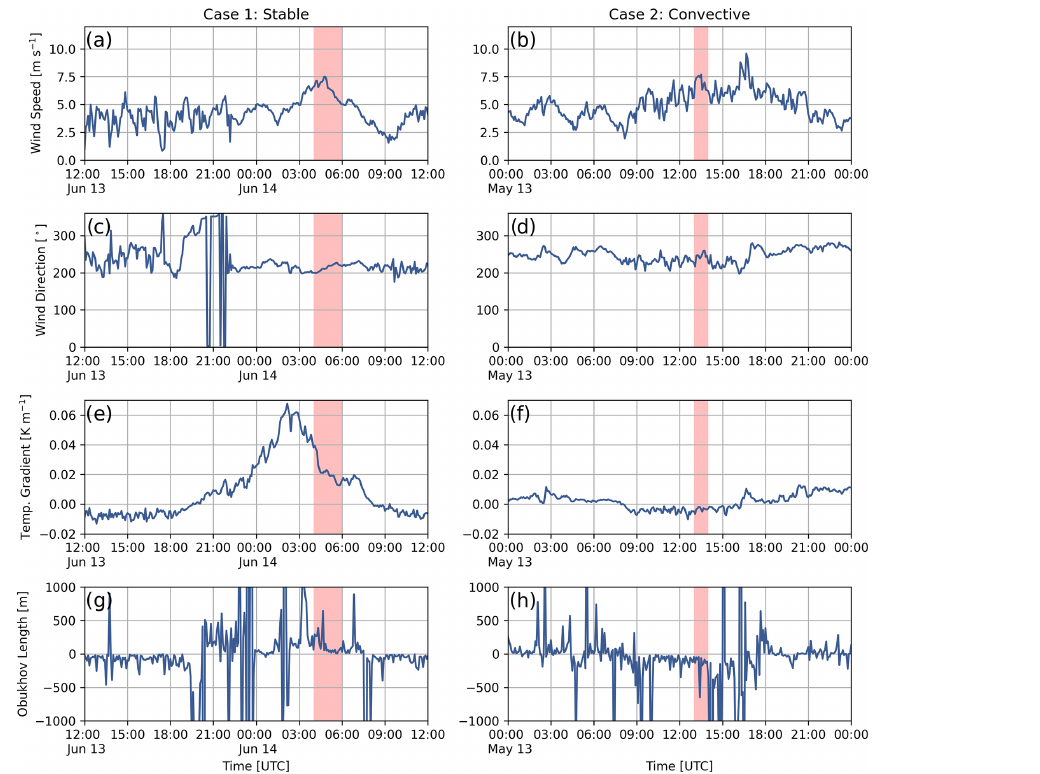
Figure 2. Hub-height (80m) wind speed, wind direction, 100–10m potential temperature gradient, and Obukhov length for the stable case and for the convective case. Data are from SW_TSE04, and the periods of interest are highlighted in red. Data have been subsampled to 5min